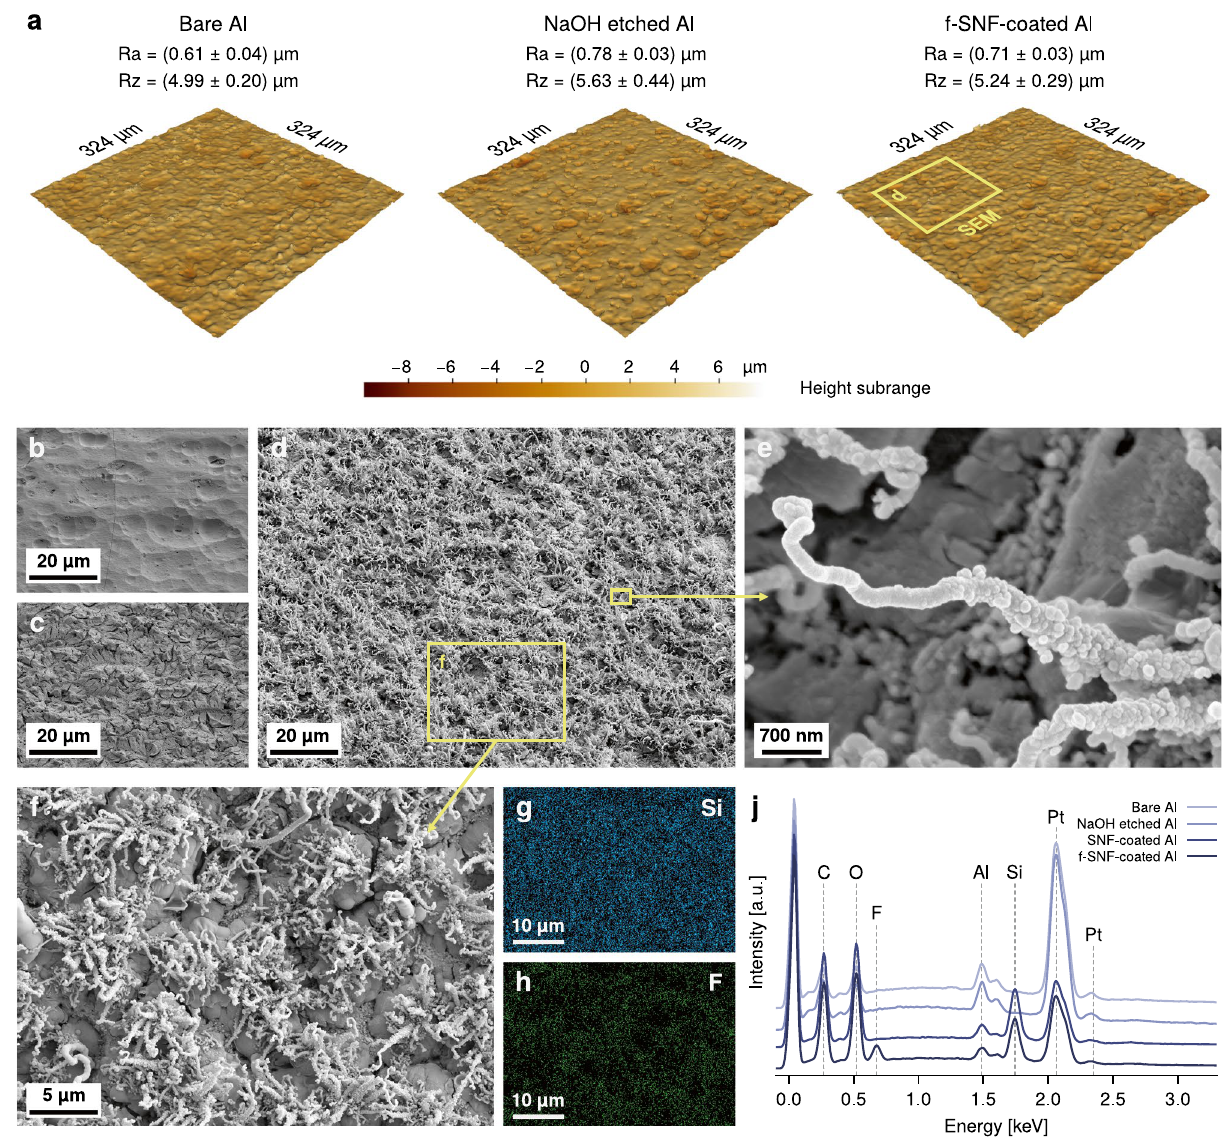
bare Al substrate, ( c ) NaOH etched Al substrate, and ( d , e) sample F. ( f ) SEM micrograph of sample F, with its EDX maps of ( g ) Si and ( h ) F. ( j ) EDX spectra of bare Al substrate, NaOH etched Al substrate and SNF-coated Al before and after